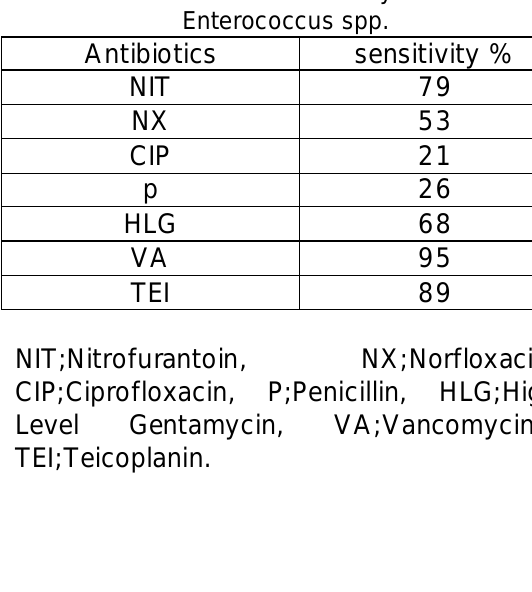
Table 5: Antibiotic Sensitivity Pattern